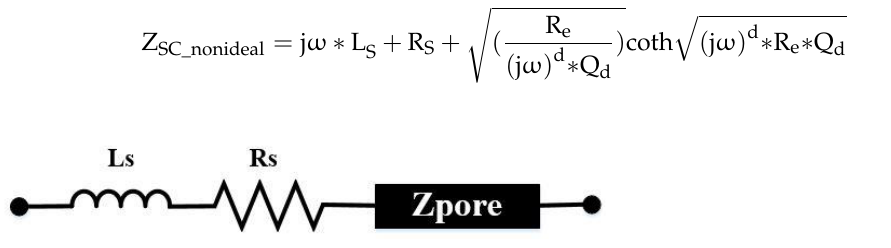
Figure 1. Equivalent circuit model of supercapacitor.